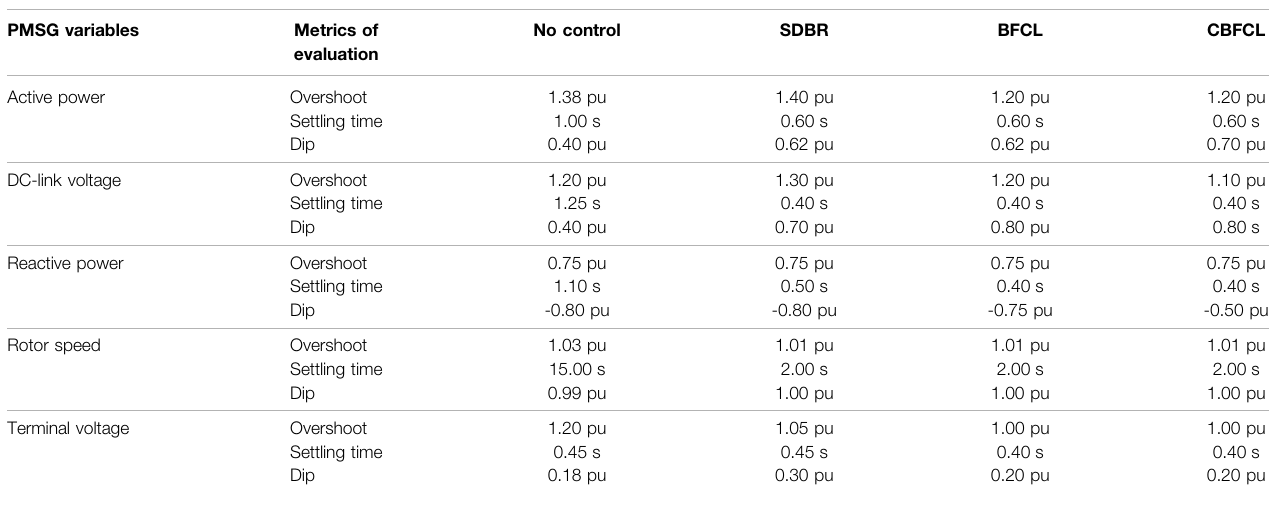
TABLE 3 | Numerical index performance of the fault current limiters. PMSG